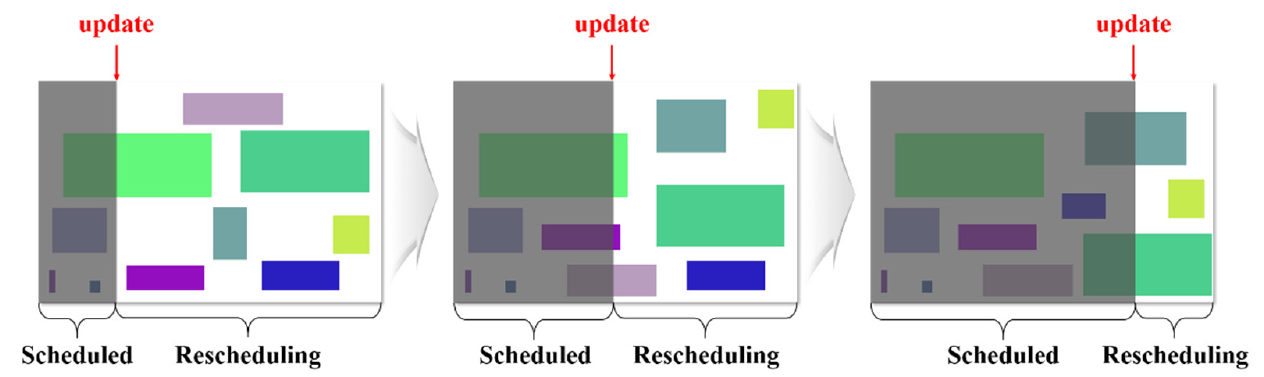
Figure 4. Rolling-horizon with reallocation of berth and QCs.